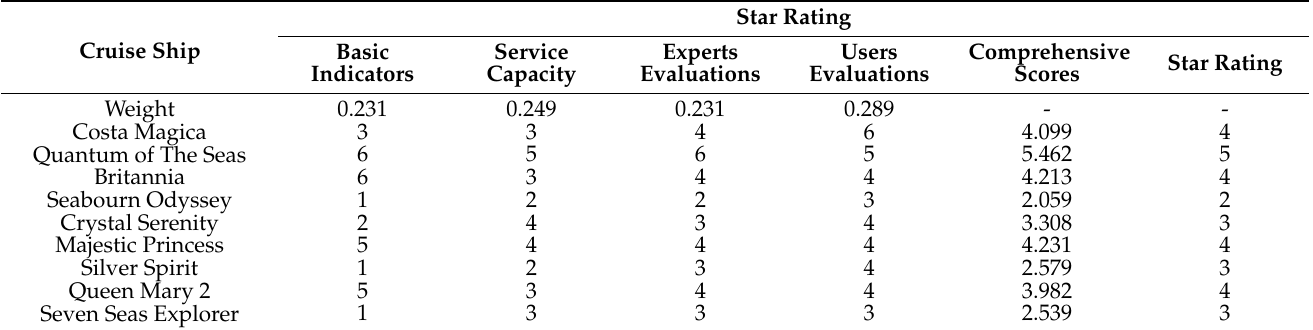
Table 12. The comprehensive star rating results of ten cruise ships.